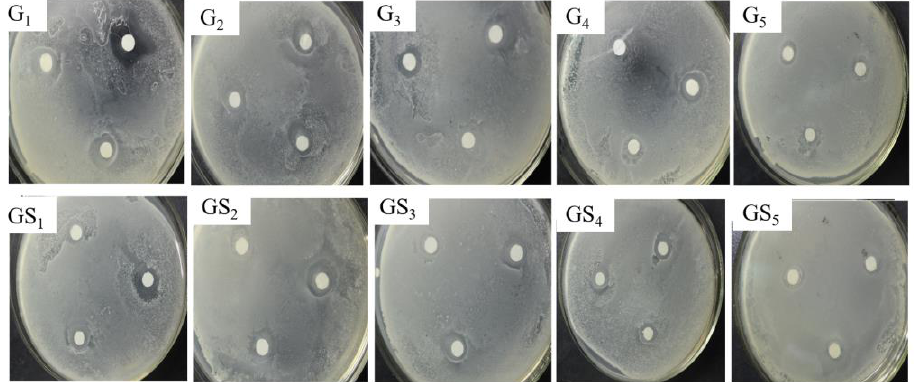
Figure 8. Inhibitory effect of purified components from DHP on the growth of S. aureus. Legend: